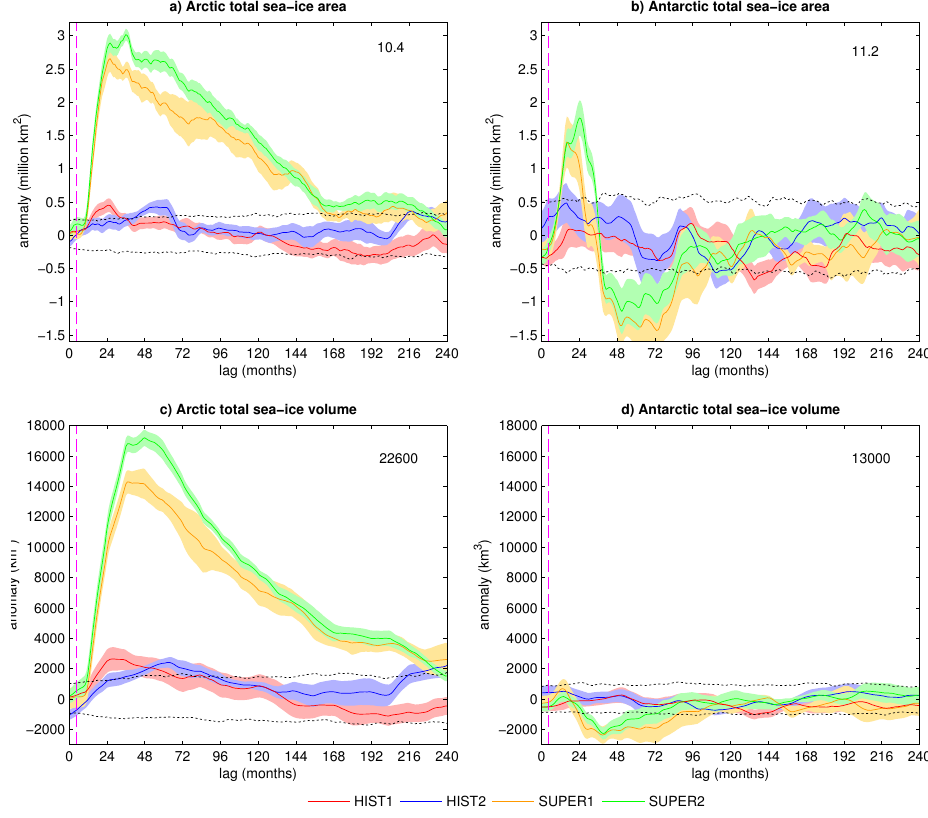
Figure 3. Simulated post-eruption anomalies of Arctic (left) and Antarctic (right) total sea-ice area (top panels) and volume (bottom) for the two historical and the two supervolcano ensembles. Lines and shading represent the mean anomaly and the standard error of the mean respectively. Anomalies are smoothed with a 13-month centered moving average. Black dashed lines indicate the internal variability range ( n = 10; see methods). The dashed vertical magenta line indicates the approximate start of the eruptions. Lag(0) corresponds to January of the eruption year. The number on the top right of each panel is the approximate pre-eruption climatology. The y axis has the same scale in panels (a) and (b) as in panels (c) and (d) , highlighting the different magnitude of the hemispheric